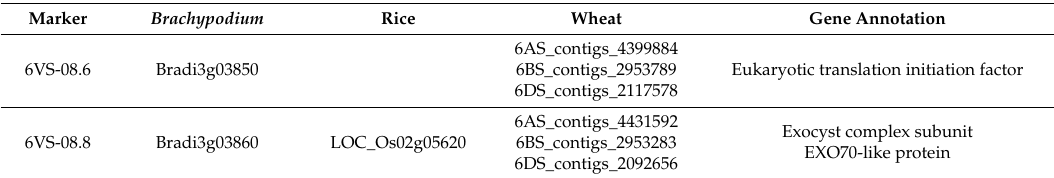
Table 2. Gene annotation in Brachypodium , rice and wheat orthologous regions of the bin FLb4–b5/b6 carrying